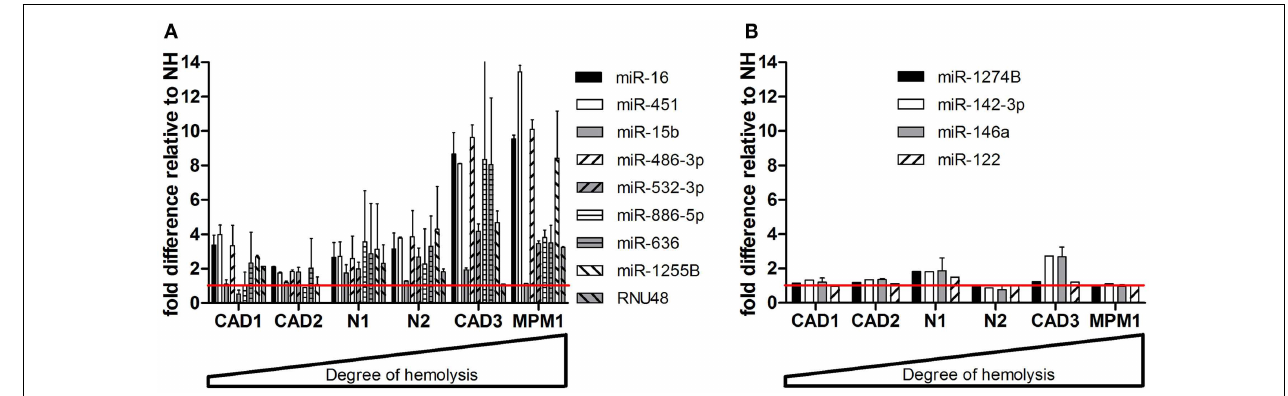
non-hemolyzed sample value obtained from measurements in RNA from two independent isolations per sample.The red line represents the relative expression of the corresponding